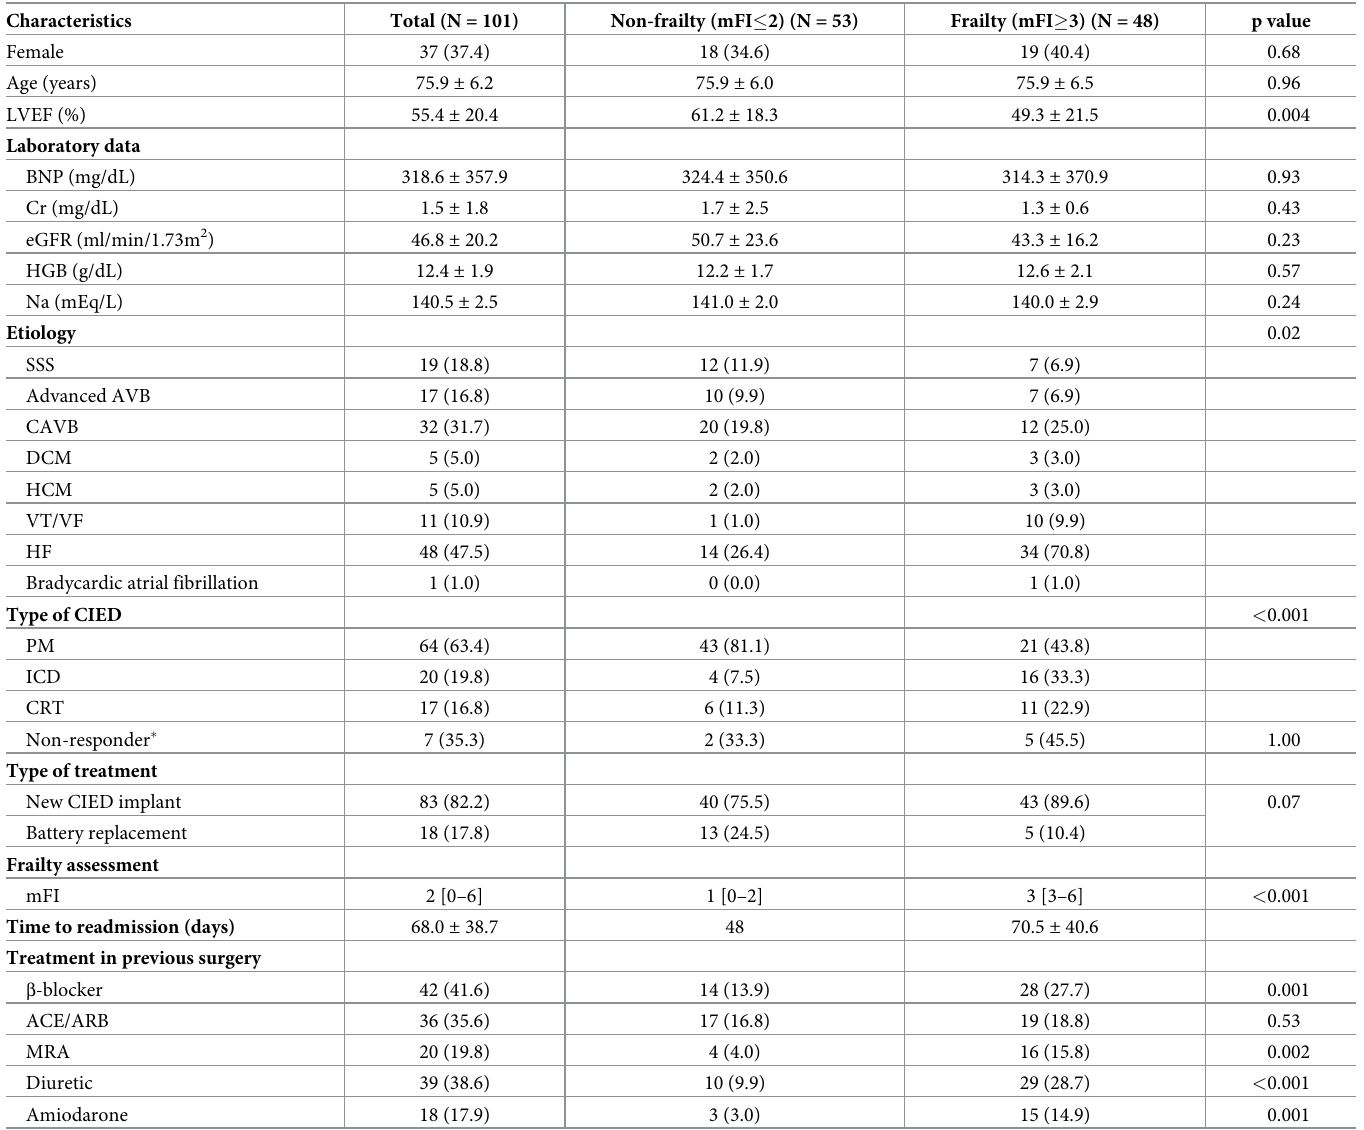
Table 1. Participant